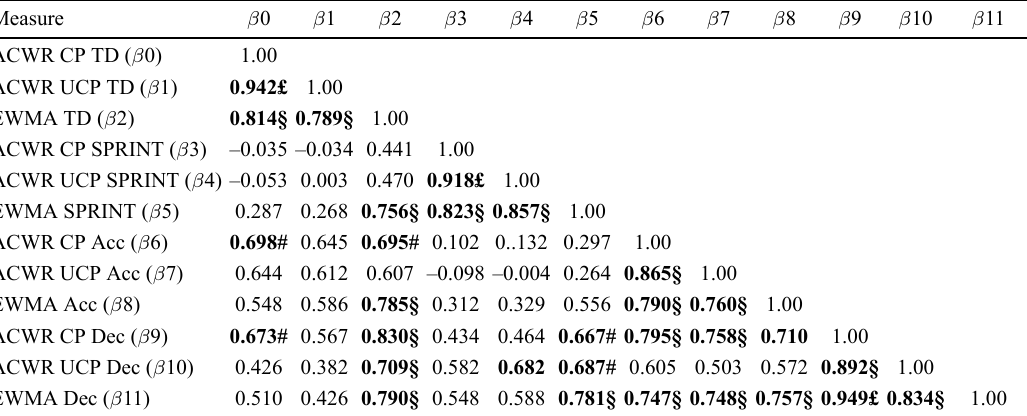
Table 4. Correlation coefficient of all measures for the non-starter’s status.